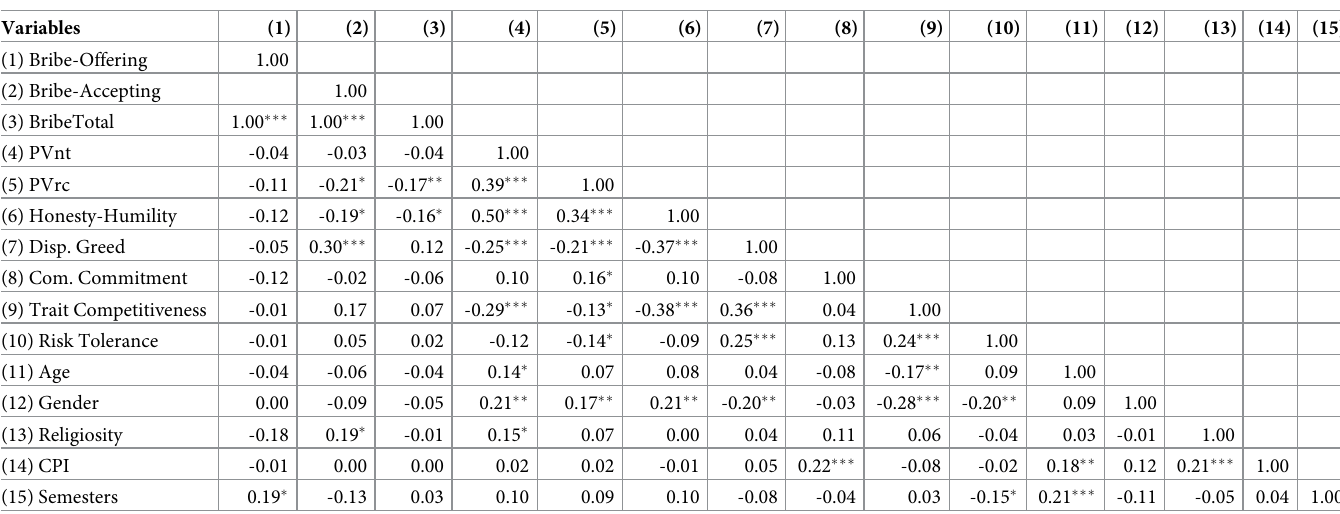
Table 2. Pairwise Pearson’s